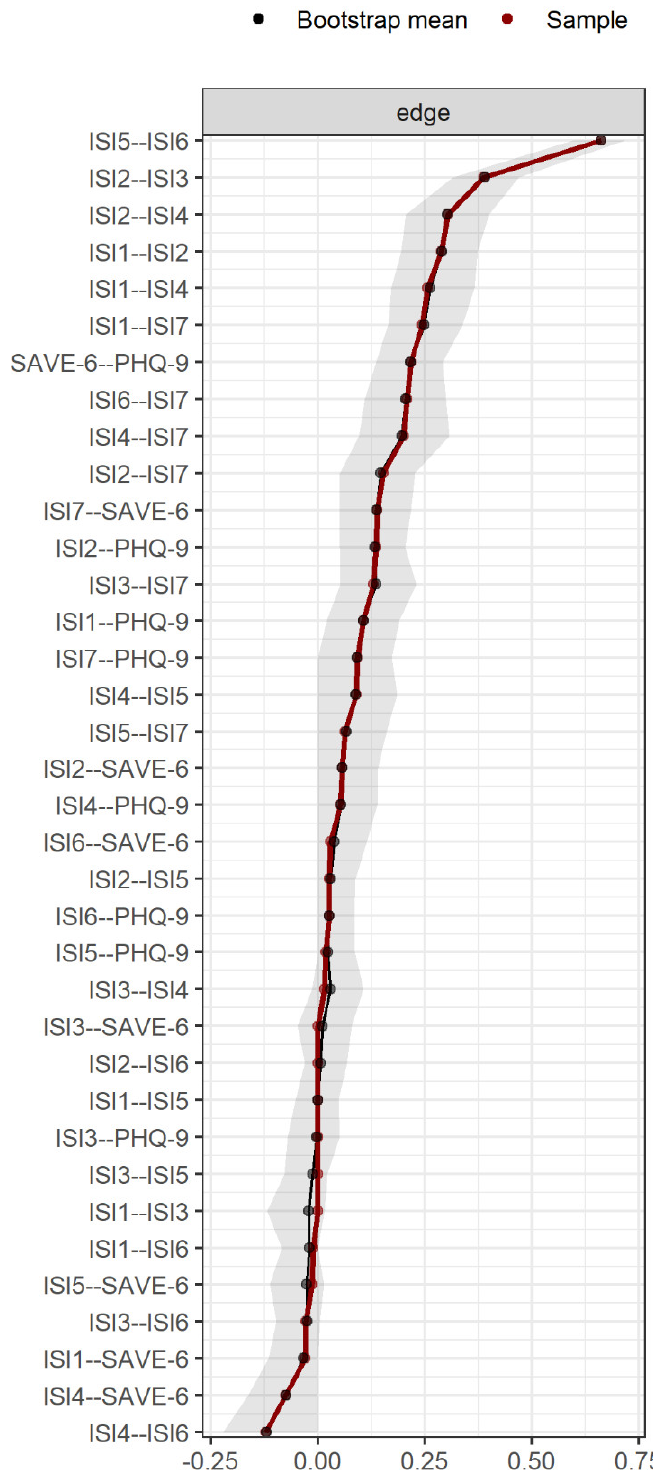
Figure 3. Bootstrapped edge-weights for each edge. Note. Edge-weights are ordered from strong to weak, top to bottom. Grey area indicates the bootstrapped confidence intervals for each edge.